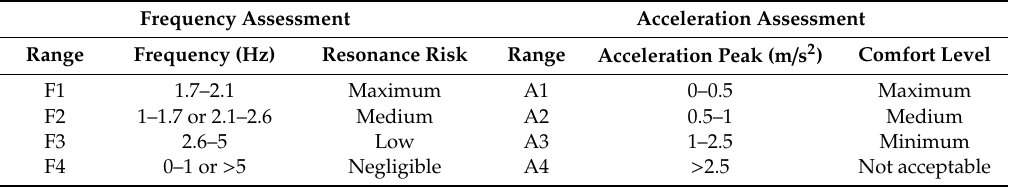
Table 4. Reference frequency and acceleration ranges (vertical direction) for the comfort assessment according to [23].